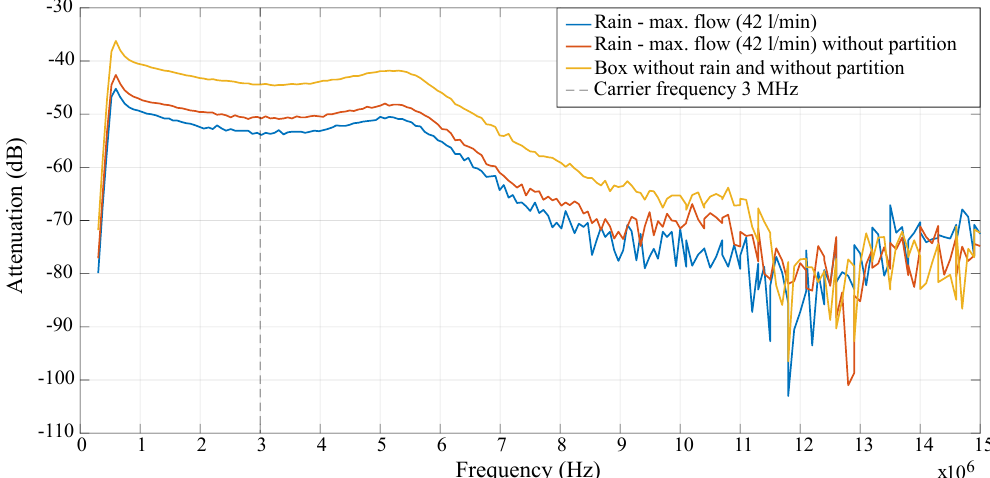
Figure 27. Attenuation characteristics of Octavia tail-light for scenario 3—Rain 42 L/min—comparison of intended setup and adjusted setup without partition.